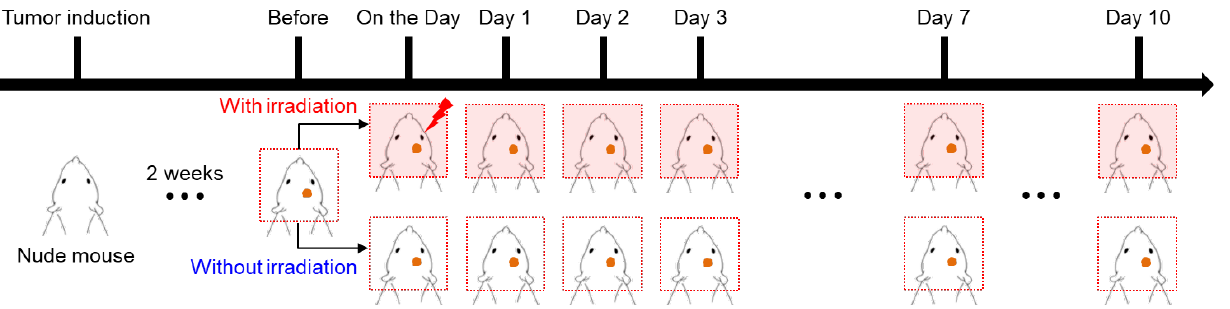
Figure 1. Schematic illustration of the experimental setup for MR-based electrical conductivity imaging to measure the effects of irradiation on in vivo mouse brain tumors.